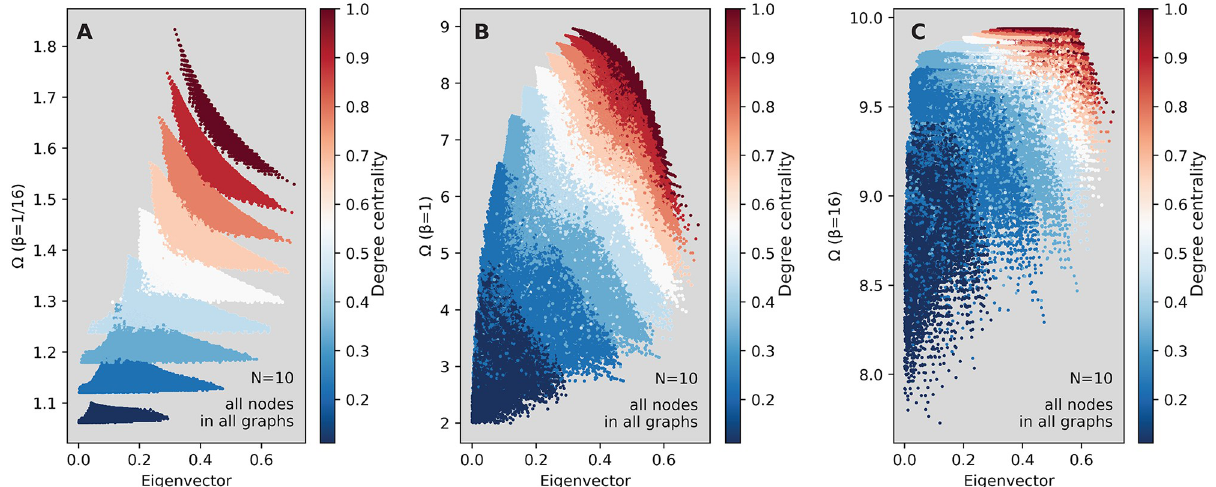
Fig 4. How the expected outbreak size O varies with a spectral centrality measure and the node degree across all small graphs. Panels A, B and C show O for any node starting an outbreak, in any graph of size N = 10, against the eigenvector centrality of that node. Panel A shows data for β = 1/16; B for β = 1 and C for β = 16. The color denotes the degree centrality.